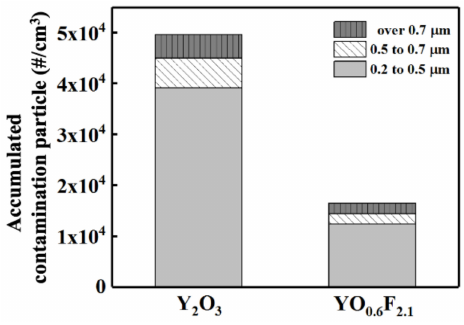
Figure 6. Size distribution of contamination particles, over 0.2 µ m size, generated from Y 2 O 3 and YO 0.6 F 2.1 during the 60 min NF 3 plasma treatment.